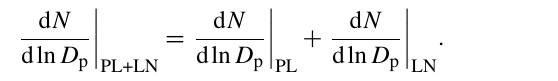
Figure 2. Intermodal processes between the PL and the LN distribu- tions. Particles larger than D coag (green area) form particles larger than D 2 by the intramodal coagulation in the PL distribution; the coalesced resultant particles are transferred to the LN distribution. When the LN distribution exists, particles of the both distributions begin to coagulate intermodally; the resultant particles are assigned to the LN distribution. Condensation grows the largest particle di- ameter by g(cid:49)t in a time step of (cid:49)t , but the condensational transfer transfers a part of the particles larger than D 2 (blue area) to the LN